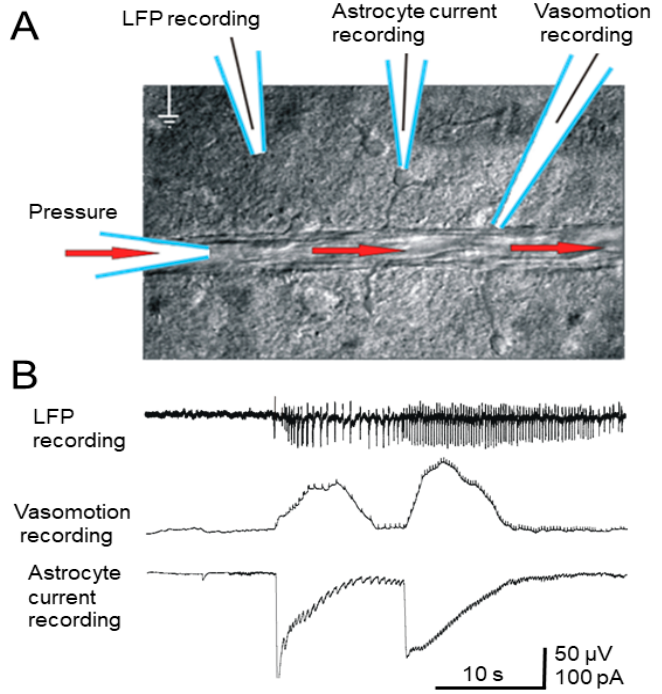
Figure 4. ( А ) Positioning of the blood vessel perfused with ACSF (30 torr) and recording electrodes. ( B ) Simultaneous extracellular LFP, vasomotor, and astrocyte patch-clamp recording after 4-AP application (see text). Low-voltage, high-frequency components superimposed on the vasomotor response, but did not reflect actual vasodilation, reflecting neural spikes.